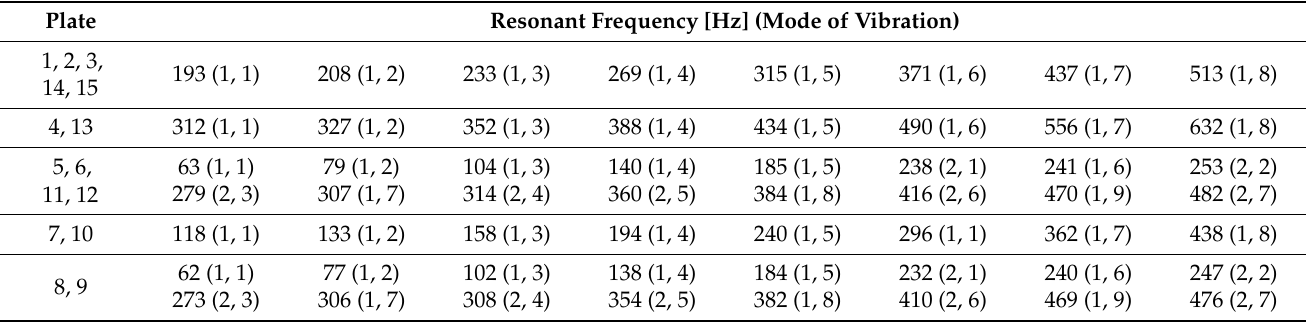
Table 2. Resonant frequencies and modes of vibrations of 15 transformer plates calculated